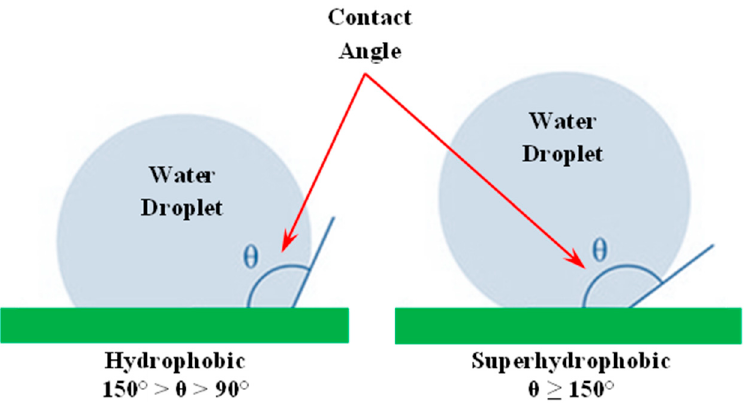
Figure 4. Contact angles required for hydrophobicity and superhydrophobicity. This figure has been created by the authors based on the concept illustrated by Koch et al. [72].